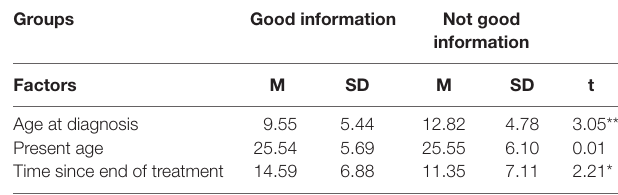
TaBle 1 | information groups by age at diagnosis, present age, and time since end of treatment (means and sD). groups good information not good